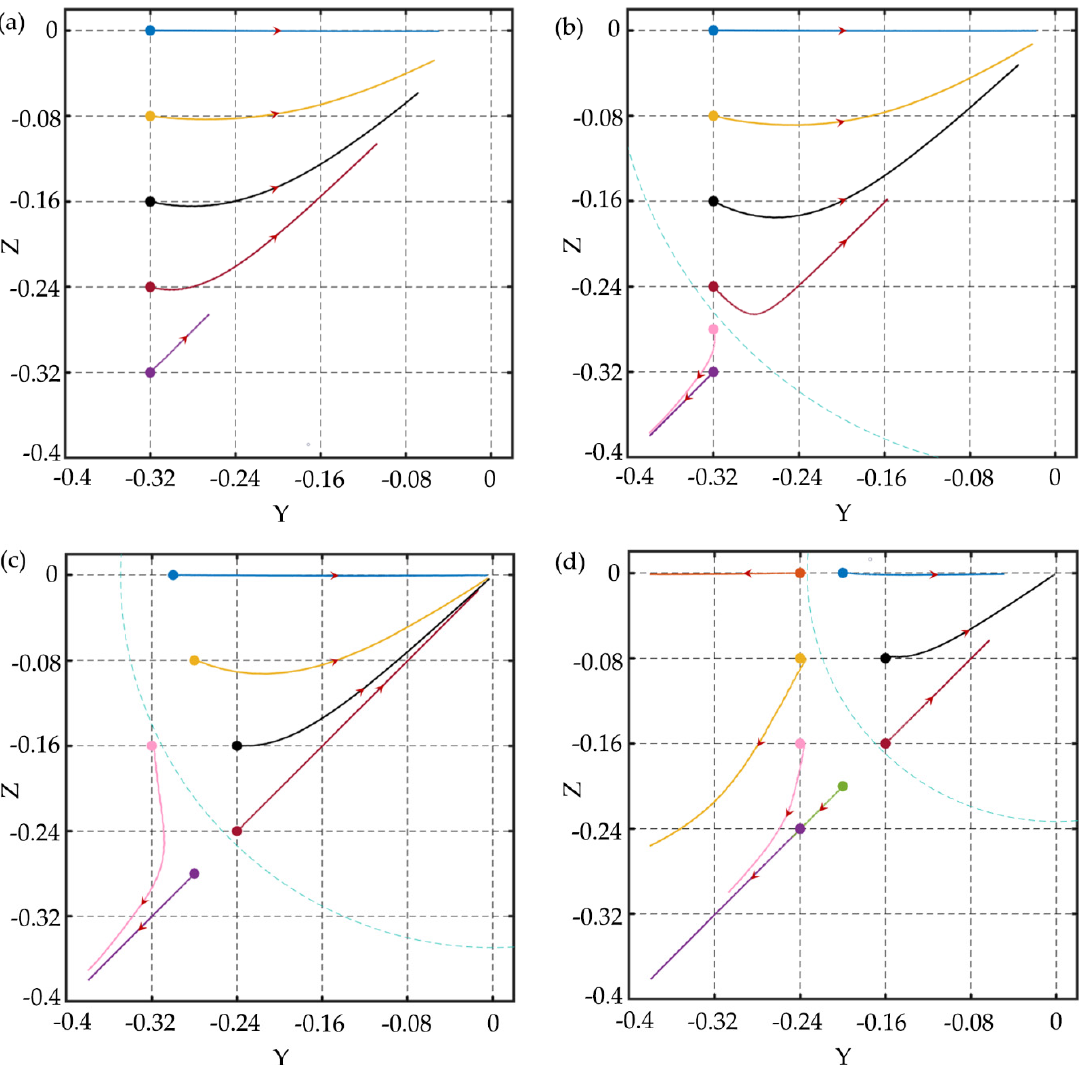
Figure 5. The migration trajectories of particles at different initial positions of the cross-section in the square channel under Re = 1.0, ( a ) Wi = 0.05, El = 0.05; ( b ) Wi = 0.1, El = 0.1; ( c ) Wi = 0.3, El = 0.3; ( d ) Wi = 0.6, El = 0.6. In ( b – d ), the blue dotted lines are the separatrices. The maximum simulation time in the figures is 1,200,000 dimensionless time units.